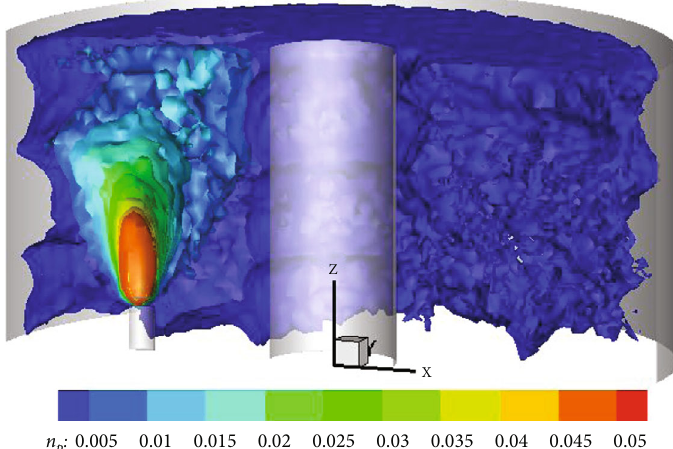
Figure 8: Distribution of primary electron density with the collision process.